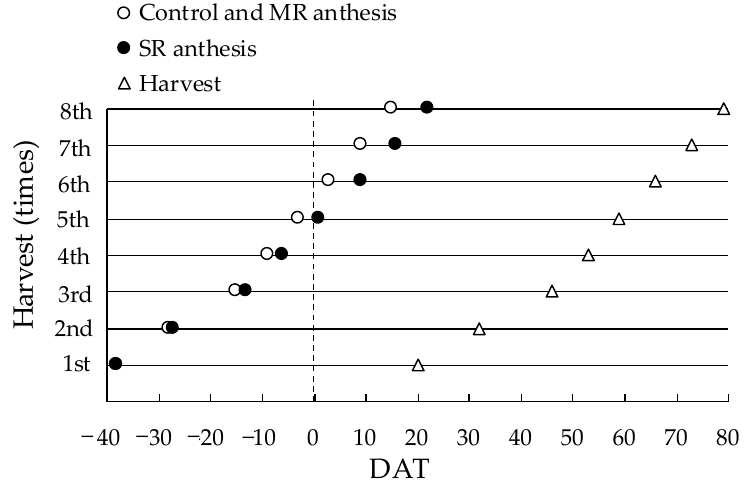
Figure 2. The anthesis and harvest dates of eight fruit harvests in the control, moderate wilting– full recovery treatment (MR), and severe wilting–full recovery treatment (SR). DAT: days after commencing treatments.